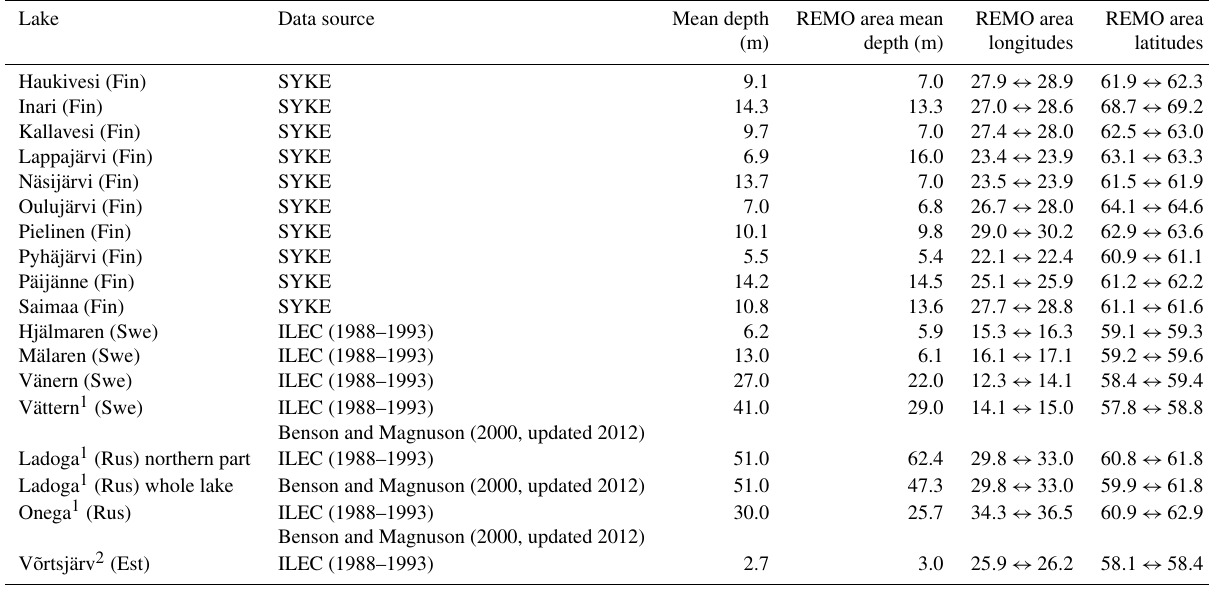
Table 2. Analyzed lakes with their mean depth, mean depths applied in REMO and the lake area information for the REMO analysis (SYKE refers to the Finnish Environment